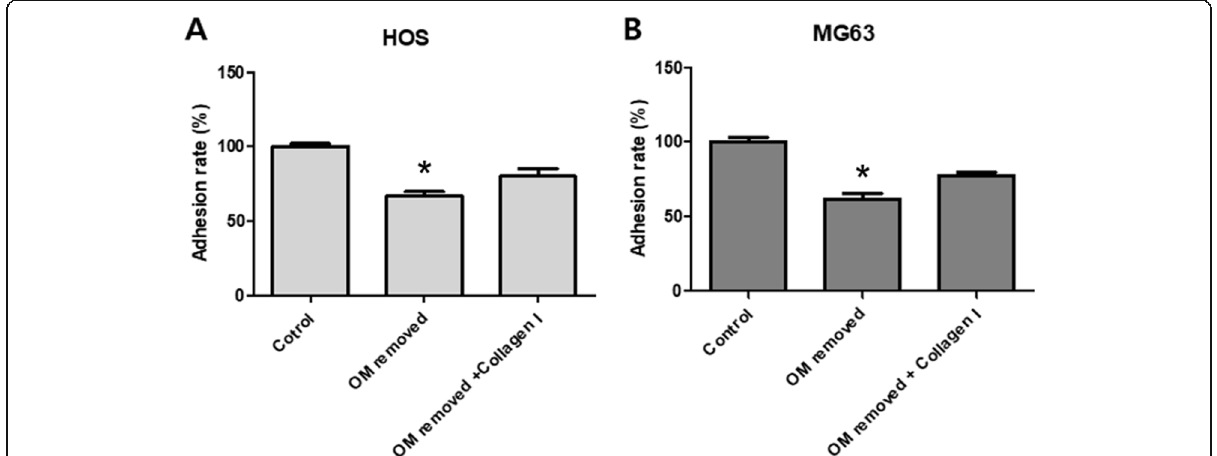
Fig. 3 A graph showing the cell adhesion activity of HOS cells ( A ) and MG63 cells ( B ). Each value represents the mean ± S.D. * p < compared